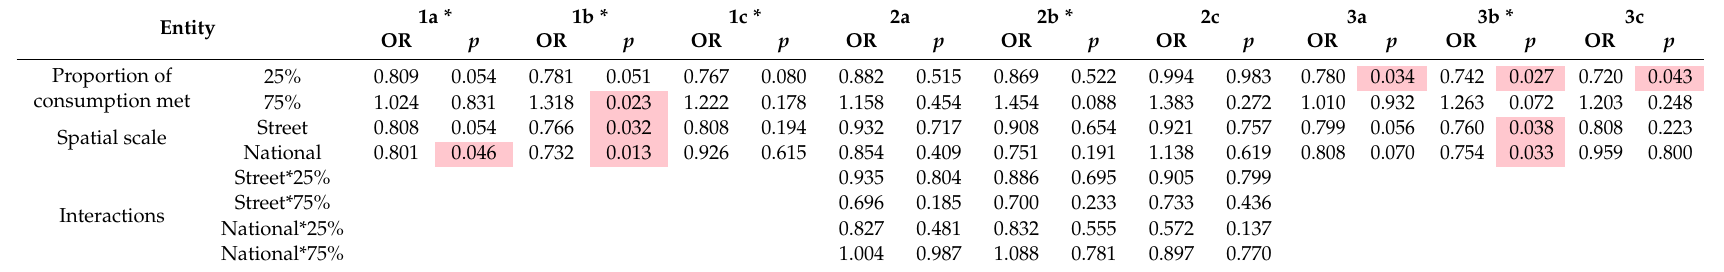
Table 4. Logistic regression results for Experiment 1. Results shown are the odds ratio (OR) and p-value, with values lower than 0.05 shaded in red. An asterisk (*) is used to indicate those analyses which we did not pre-specify in our PAP. Model 1 included main e ff ects only; model 2 added interaction terms; and model 3 also included other (e.g., demographic) variables—see methods section for full list. In each case, the model was run for three samples: (a) the full sample, (b) only those who passed manipulation check 1, and (c) only those who passed both manipulation checks. All significant p-values withstood correction for false discovery due to multiple comparisons by the Benjamini-Hochberg test